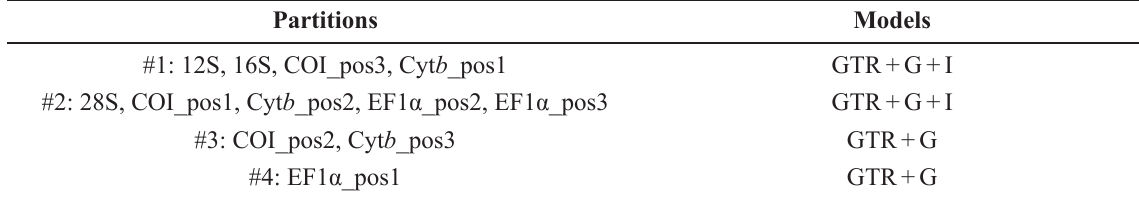
Table 2. Results of PartitionFinder analyses, based on the